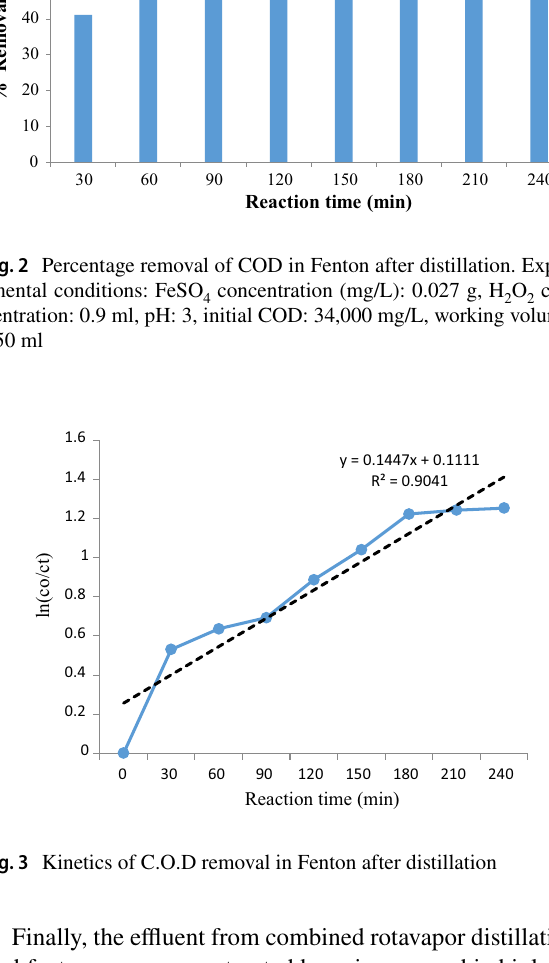
Fig. 3 Kinetics of C.O.D removal in Fenton after distillation